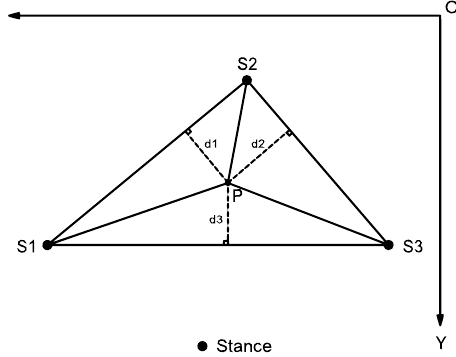
Figure 11. Geometric analysis of static gait stability. The mathematical relationship after converting the stability conditions corresponding to the robot stability is (cid:52) S 1 S 2 S 3 , and the sum of the areas of the three triangles divided by point P is equal to (cid:52) S 1 S 2 S 3 . The specific geometric analysis is shown in Figure 12.